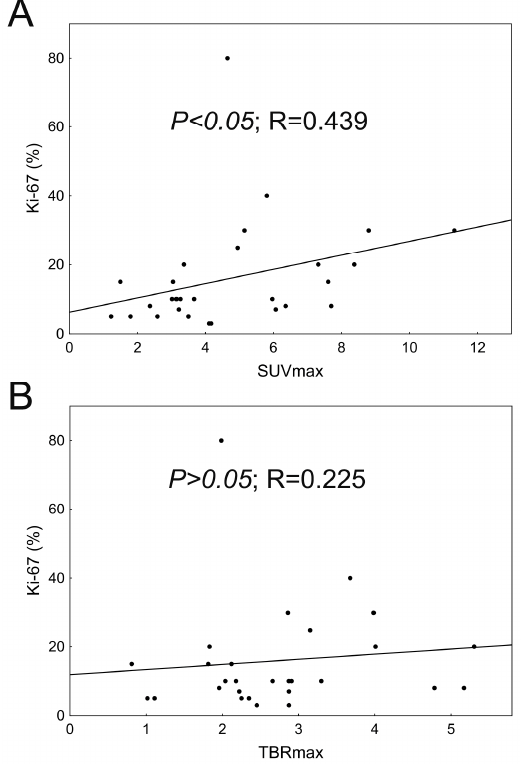
Figure 5. The association of SUVmax ( A ) and TBRmax ( B )with Ki-67 (Spearman’s rank order corre- lation).